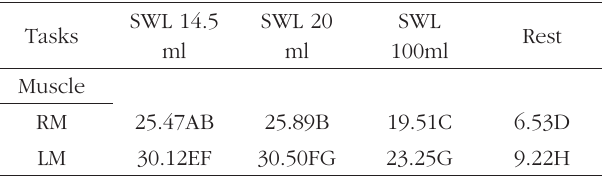
Table 2. Comparison of the percentage means of electrical activity of the masseter muscle during swallowing and rest in swallowing tasks performed by post-total laryngectomy